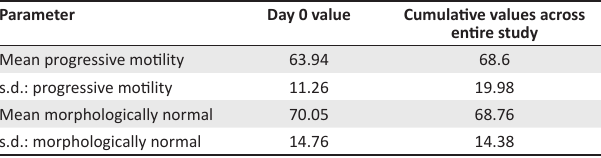
TABLE 2: Percentage progressive motility and live, morphologically normal sperm of vaccinated and control groups assessed together. Parameter Day 0 value Cumulative values across